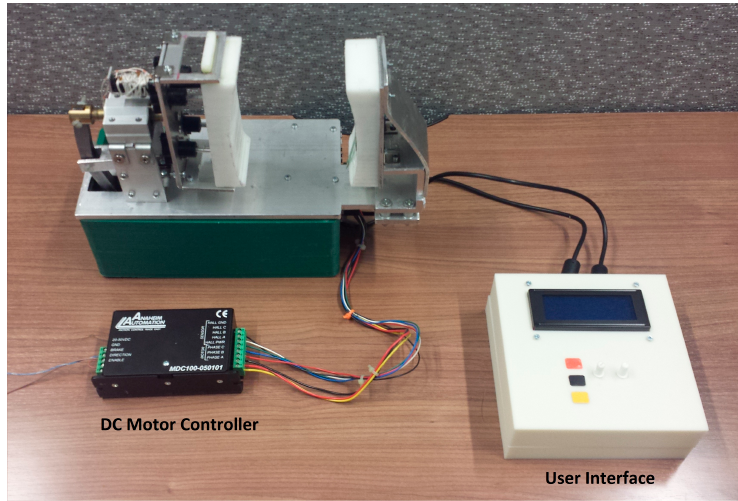
Figure 14. Experimental setup of the knee-loading device.